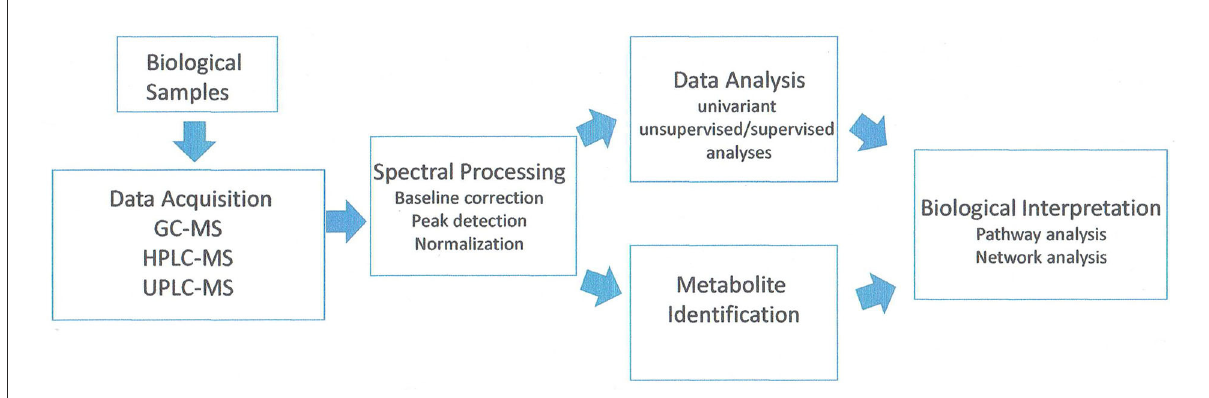
FIGURE3 Analysis of workflow in untargeted metabolomic studies. Adapted from Alonso et al.